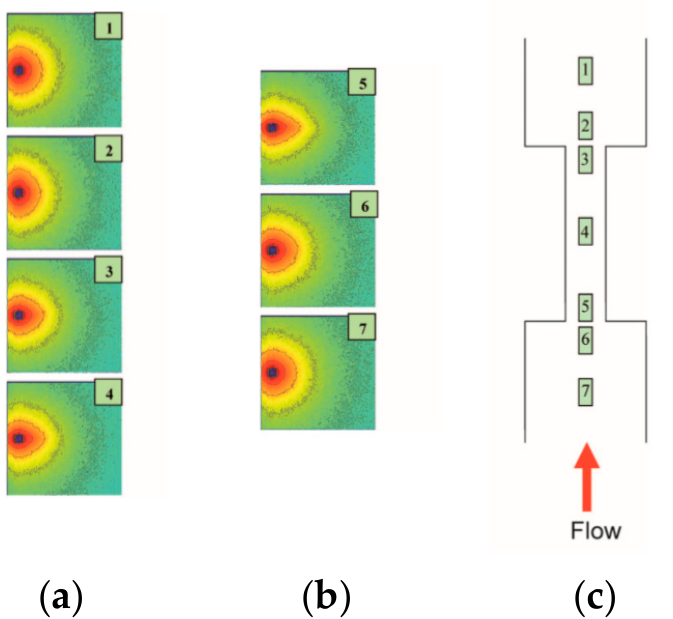
Figure 6. 2D scattering patterns from a material encountering an obstruction using a pressure-driven slot flow cell ( a , b ). The neutron beam is directed at right angles with respect to the flow direction ( c ). The numbered boxes correspond to the different SANS patterns. The anisotropy is due to the deformation of the backbone of the comb-shaped polymer seed in this experiment (reproduced with permission from [63], ROYAL SOCIETY OF CHEMISTRY, 2009).